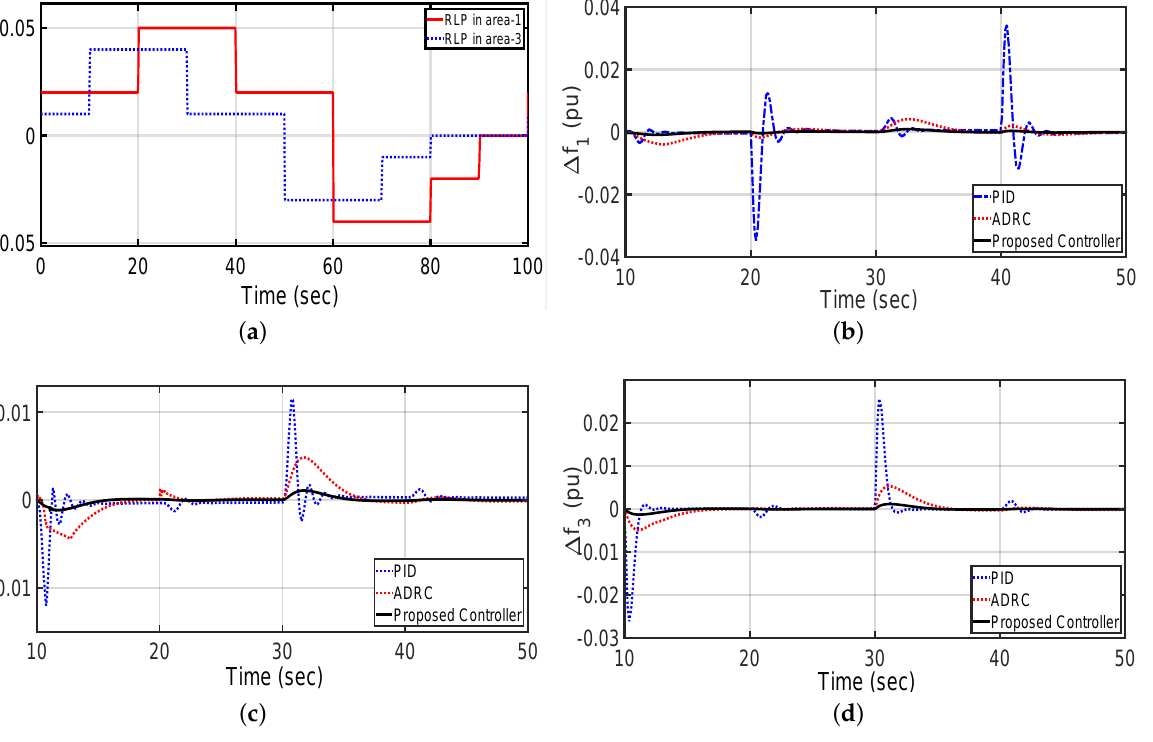
Figure 6. Response comparison of PID, conventional ADRC, and 1D-ADRC against random distur- bances. ( a ) RLP Pattern; ( b ) ∆ f 1 ; ( c ) ∆ f 2 ; ( d ) ∆ f 3